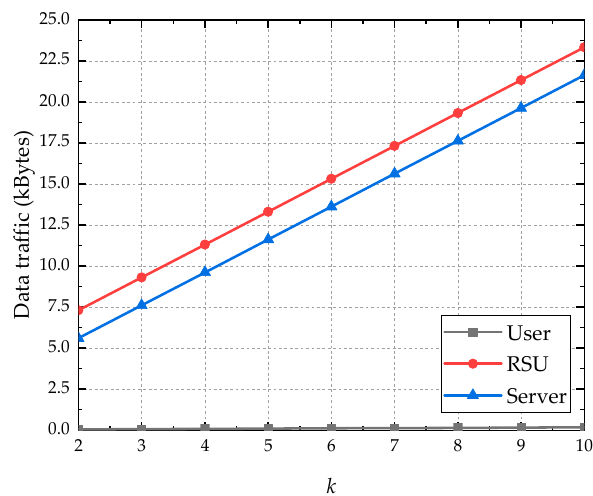
Figure 7. Impact of privacy parameter on data traffic.